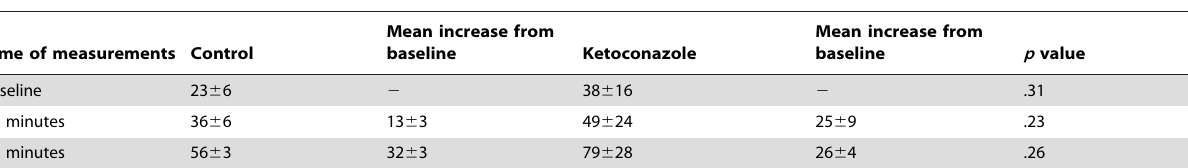
Table 2. ACTH stimulation test results.